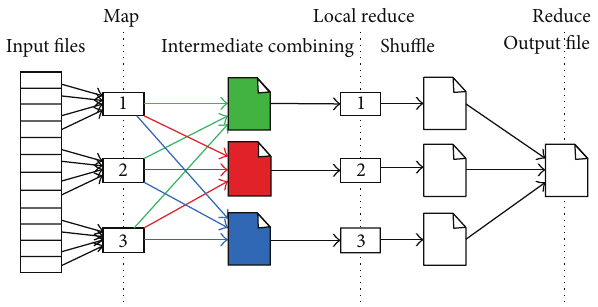
Figure 3: The procedure of Hadoop map/reduce model.